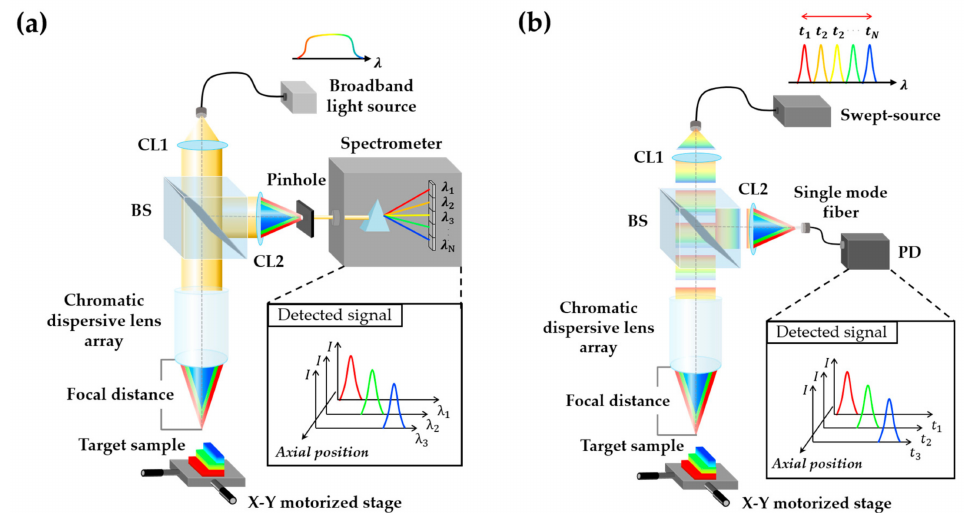
Figure 1. Schematic diagrams and data processing procedure of ( a ) the conventional chromatic confocal microscopy (CCM) and ( b ) the proposed swept-source-based CCM (SS-CCM). CL, BS, and PD are the acronyms for collimation lens, beam splitter, and photodetector,